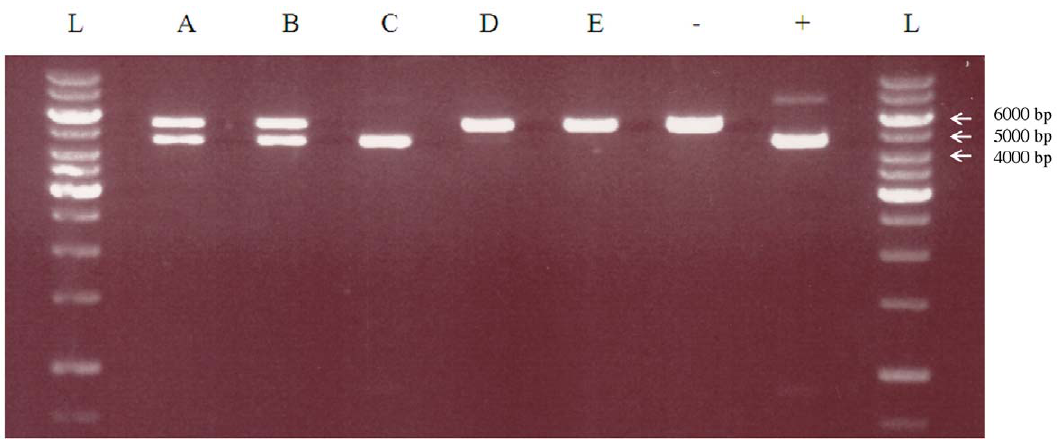
Figure 4. Digestion of 1 m g mutated phagemid DNA library pools with HindIII and SacII. (A) Kunkel 2 UDG, (B) Kunkel + UDG, (C) Kunkel 2 UDG + RCA, (D) Kunkel + UDG + RCA with exoresistant random primers, (E) Kunkel + UDG + RCA with normal random primers, ( 2 ) SacII resistant control, ( + ) SacII sensitive control, (L) 1 kb Fermentas DNA Ladder.